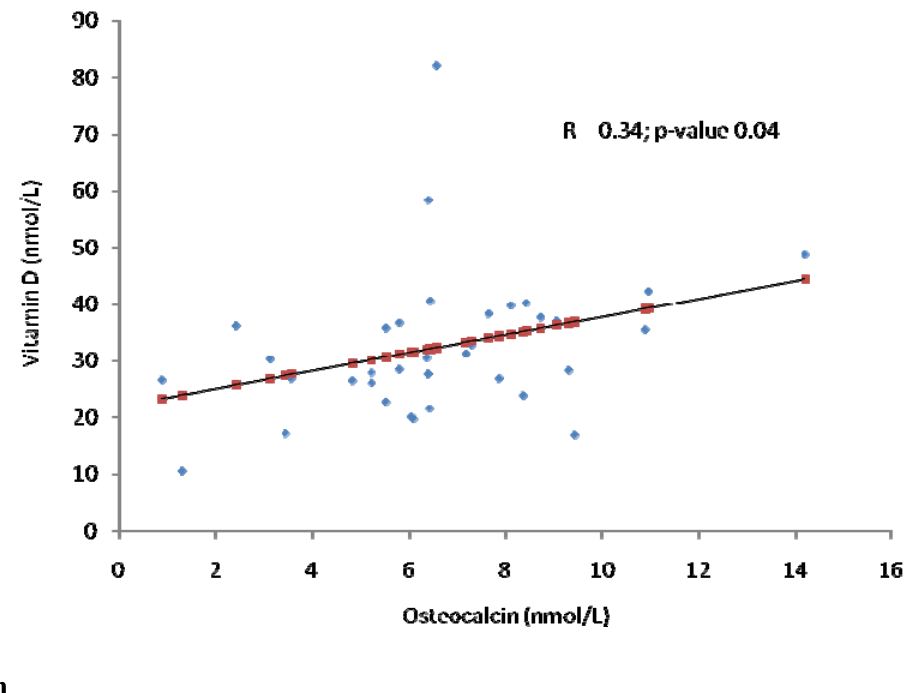
Figure 1. Modest association between vitamin D and osteocalcin (all